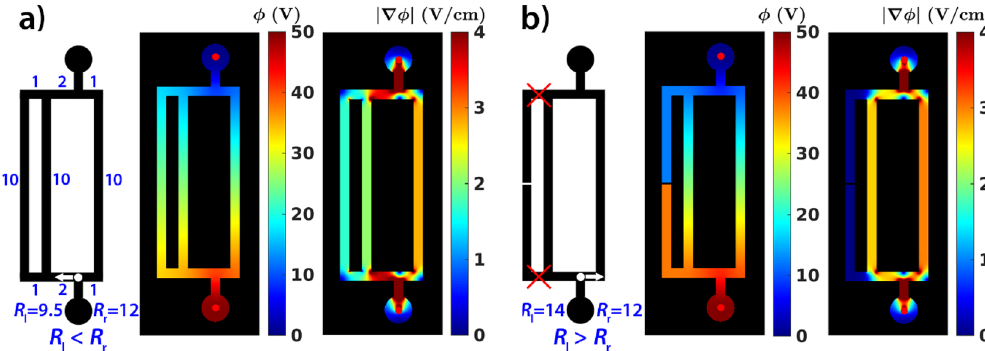
Figure 4. Path selection of a Hg droplet in two channel networks in the presence of an electric field, showing the network topology, calculated electric field potential and the magnitude of the gradient. ( a ) The T-junction near the anode has two outlets: one having a longer and parallelly connected paths (left side) and another single shorter path (right side). The net resistance of the left side of the network is smaller than that on the right. ( b ) The T-junction near the anode has two outlets: one with a single longer path (left side) and another with a shorter (right side) path. The net resistance of the left side of the network is greater than that on the right. The droplet moves in the locally lower resistance branch irrespective of the path